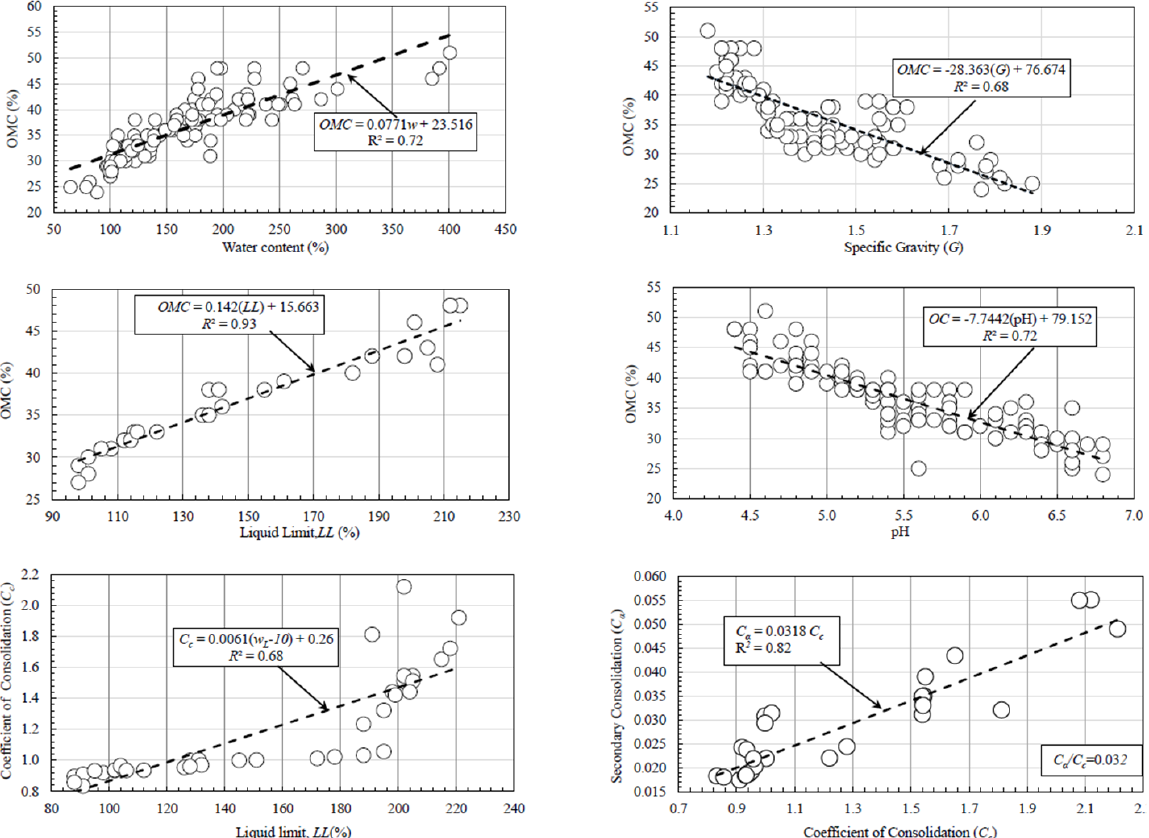
Figure 8. Proposed empirical equations of physical and engineering properties obtained for Agartala peat: (a) organic matter content (OMC) with water content; (b) Organic matter content (OMC) with specific gravity (G); (c) Organic matter content (OMC) with Liquid limit (LL); (d) Organic matter content (OMC) with pH; (e) Coefficient of consolidation (C c ) with liquid limit (LL); (f) Secondary consolidation (C α ) with coefficient of consolidation (C c